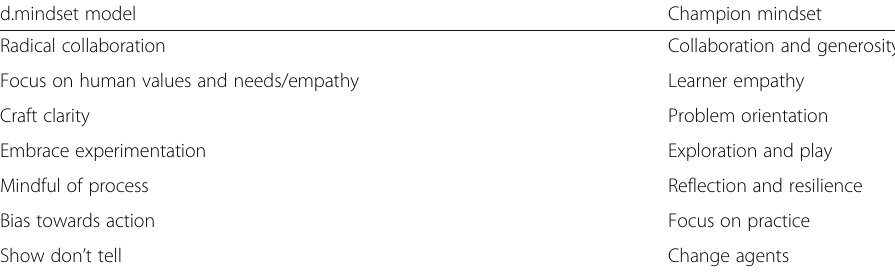
Table 2 Mapping emerging themes onto the d.mindsets model (d.school,